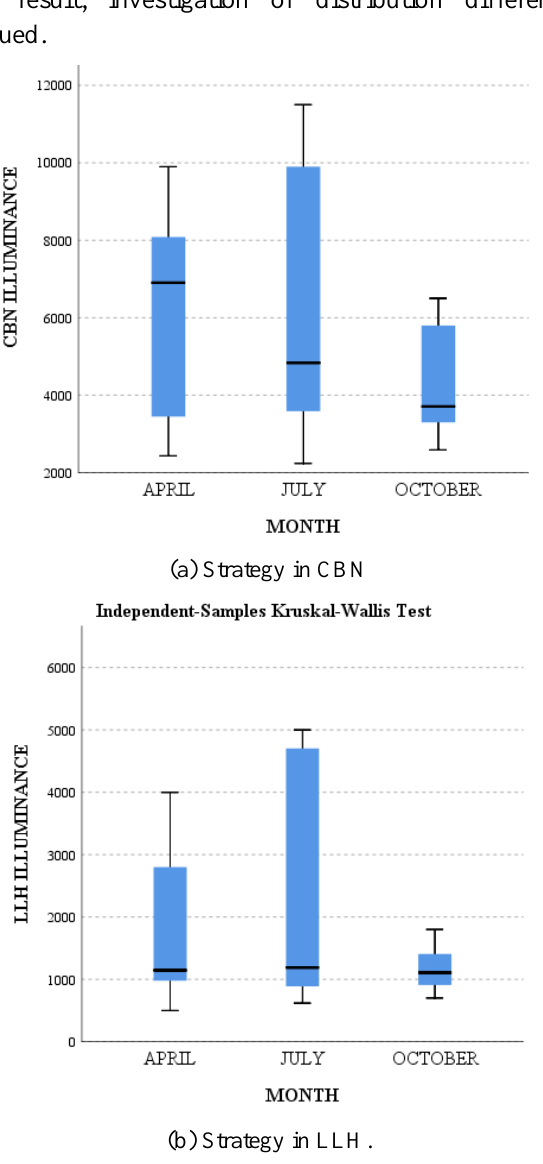
Fig. 6. Box plots showing dissimilarity of the distribution of the monthly illuminance in strategies